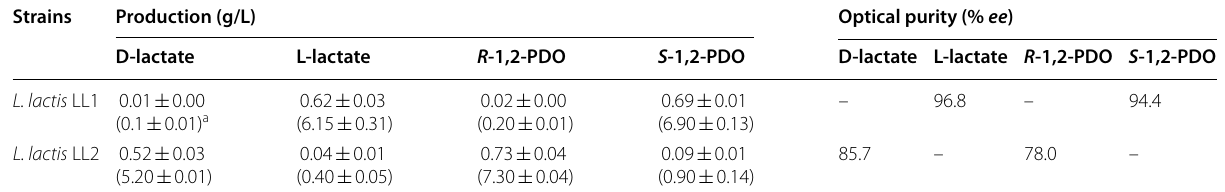
Table 1 Production profiles of D- and L-lactate and R - and S -1,2-PDO in the engineered L. lactis after 72 h of incubation with 1% glucose